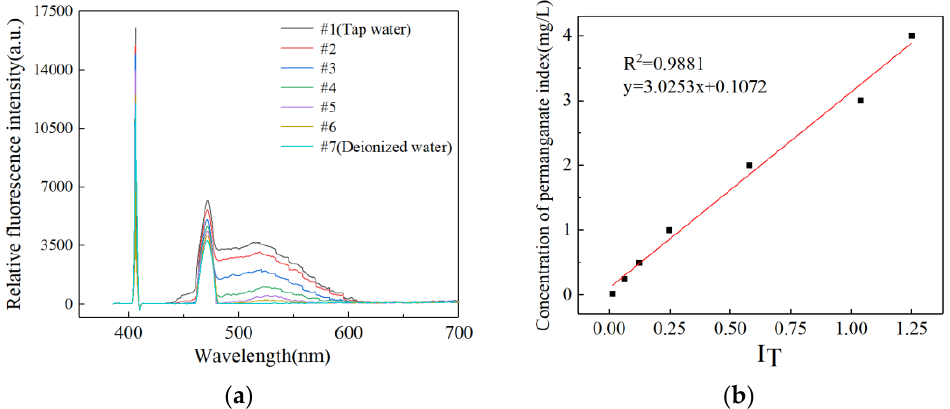
Figure 2. ( a ) The laser-excited spectra of different water samples; ( b ) The correlation between the ratio of Laser Fluorescence – Raman and the concentration of permanganate index.